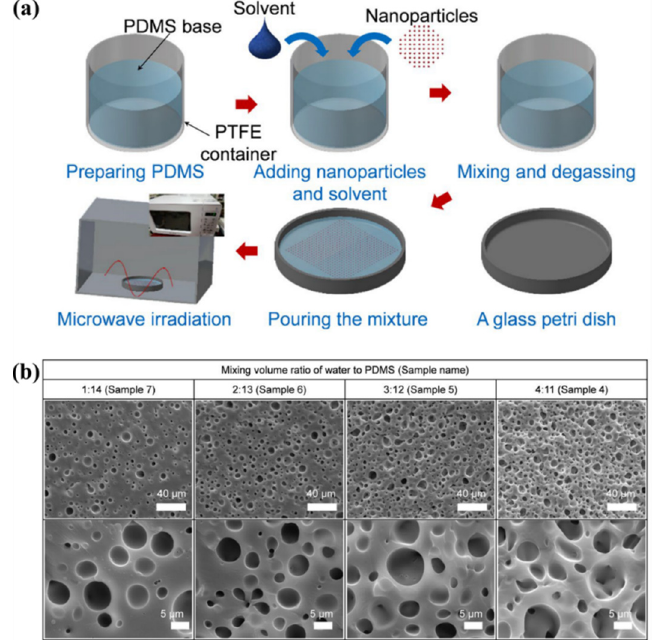
Figure 4. ( a ) Typical fabrication process of the emulsion-template method and ( b ) the cross-sectional SEM images of porous PDMS. Reproduced from [115] .